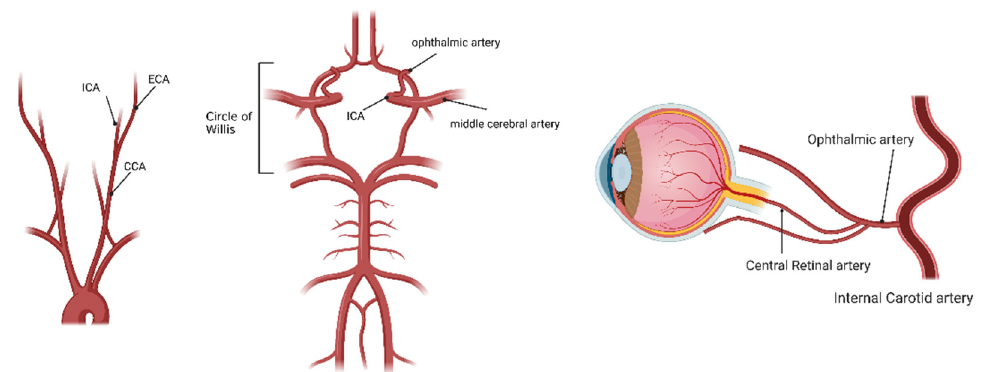
Figure 1. Ocular ischemic syndrome (OIS) development. OIS is caused by blocking the ophthalmic artery, the first branch of the internal carotid artery. CCA, the common carotid artery; ICA, the internal carotid artery; ECA, the external carotid artery. Image made with graphics from ©BioRender (biorender.com).